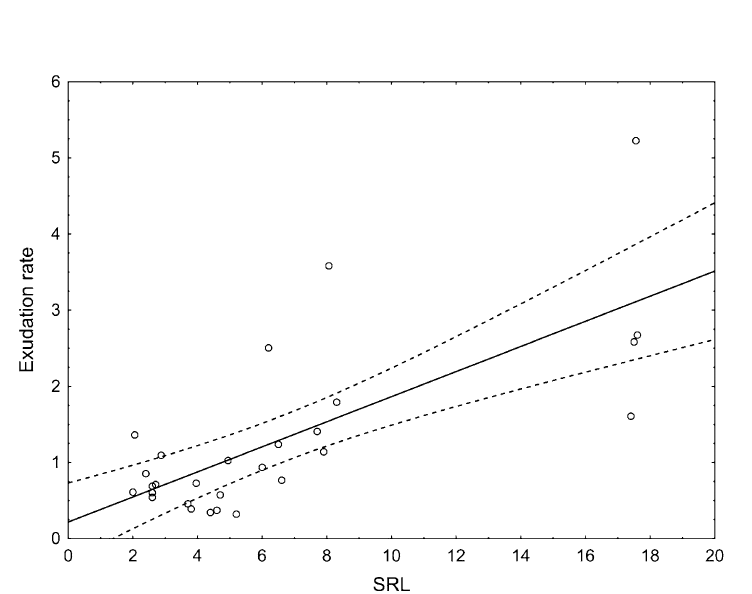
Figure 3. The positive relationship between root exudation rate (mg C g -1 day -1 ) and specific root length